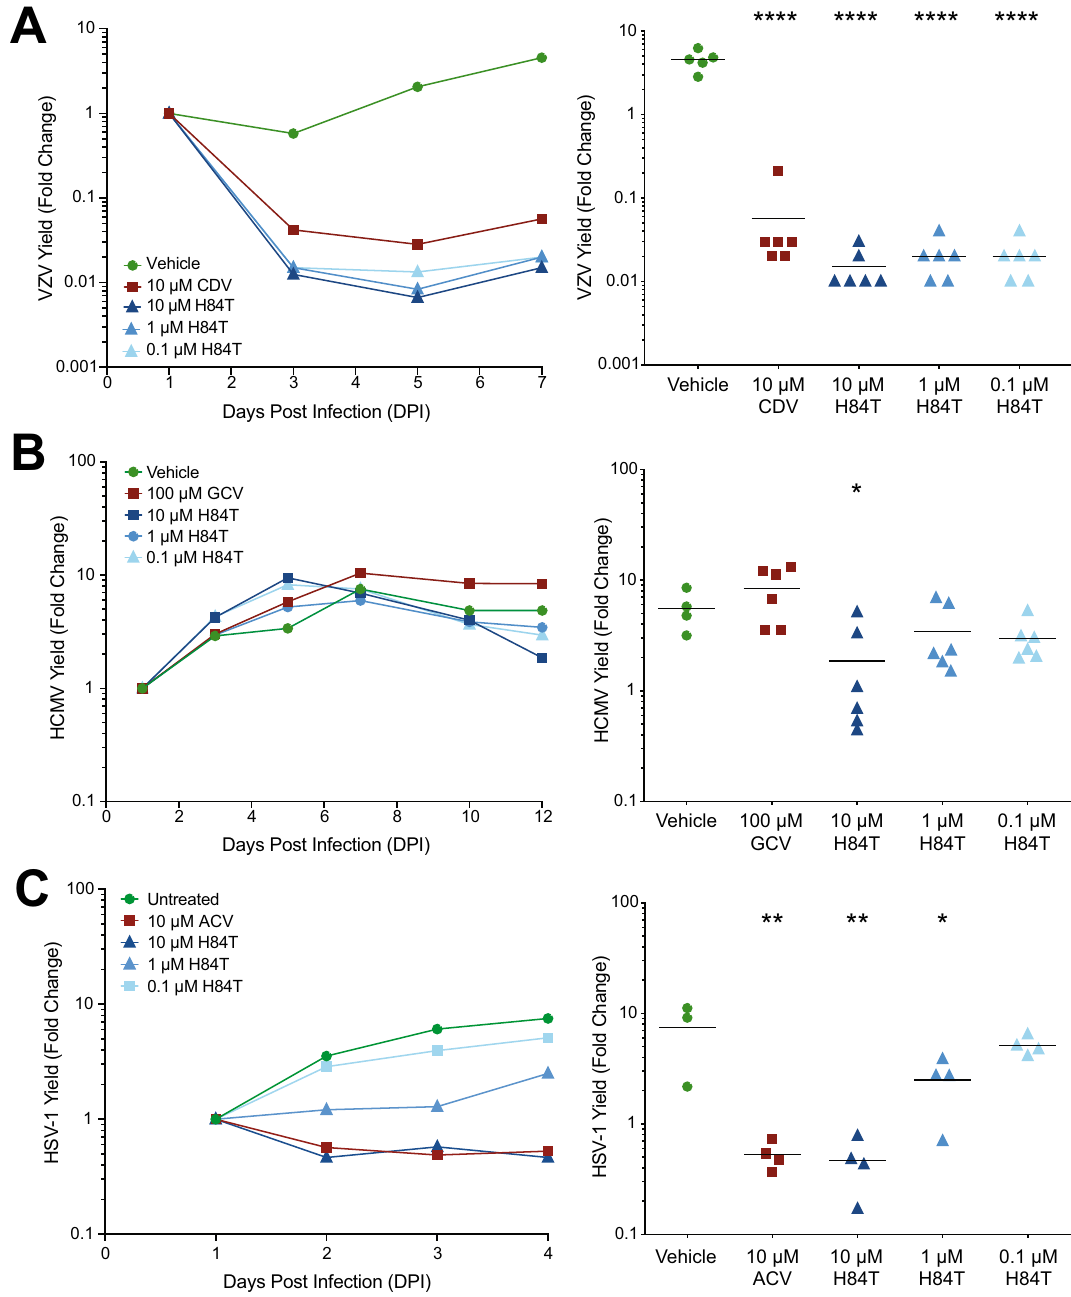
Figure 3. H84T BanLec evaluation in skin organ culture. Adult skin explants were inoculated with VZV ( A ), HCMV ( B ), or HSV-1 ( C ) and then placed on NetWells over medium that contained H84T BanLec or positive control antiviral compounds (cidofovir, CDV, 10 µM; ganciclovir, GCV, 100 µM; acyclovir, ACV, 10 µM). Virus spread was measured by bioluminescence imaging starting on 1 DPI. Virus yield on subsequent days was calculated by dividing the average Total Flux (photons/sec/cm 2 /steradian) by the average Total Flux on 1 DPI. Viral growth kinetics (left panels, each symbol is the average for the group) were analyzed for statistical significance on the last day (right panels), where each symbol represents one piece of skin and the bar is the mean of the group. Asterisks indicate significance between the treated groups and vehicle, [* p < 0.05, ** p < 0.01, **** p < 0.0001, p < 0.05, one-way ANOVA, Dunnett’s (A, C) or Dunn’s (B) post hoc test]. N = 4–6 biological